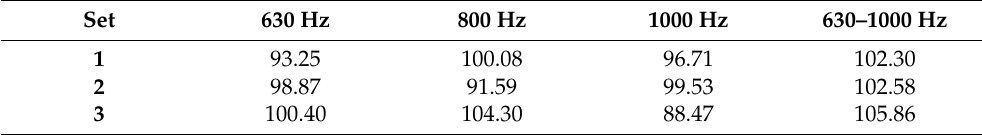
Table 5. The LA eq obtained by the numerical simulations of optimal sets of control factors (unit: dBA).